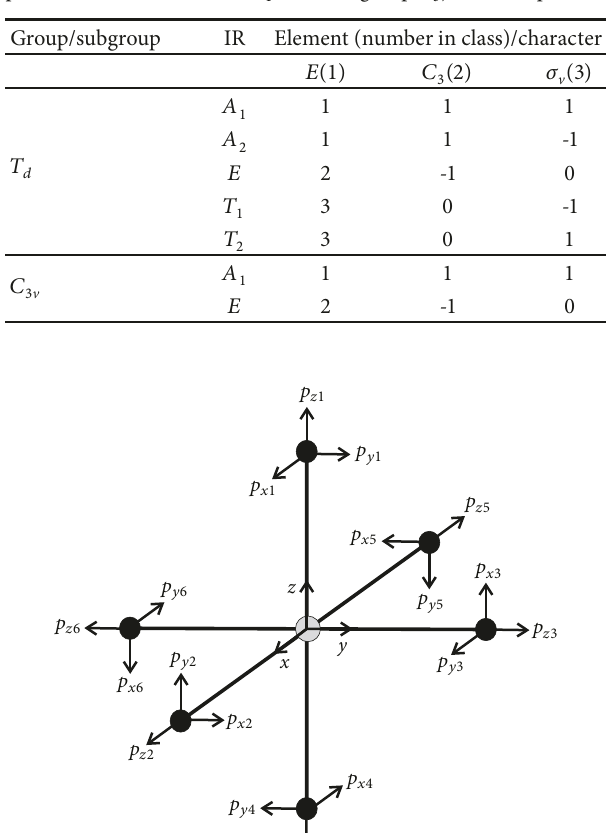
Table 1: Part of charactertable of group 𝑇 𝑑 on its subgroup 𝐶 3 V (top part) and characters of IRs 𝐴 1 and 𝐸 of group 𝐶 3 V . (bottom part).